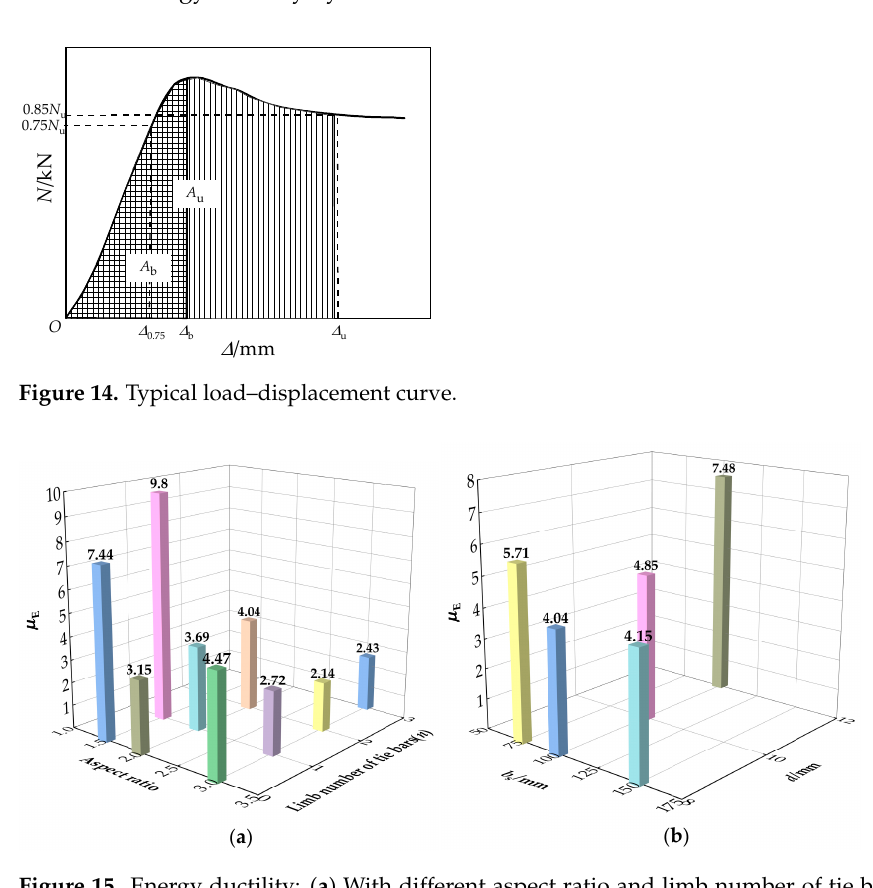
Figure 15. Energy ductility: ( a ) With different aspect ratio and limb number of tie bars; ( b ) With different b s and d